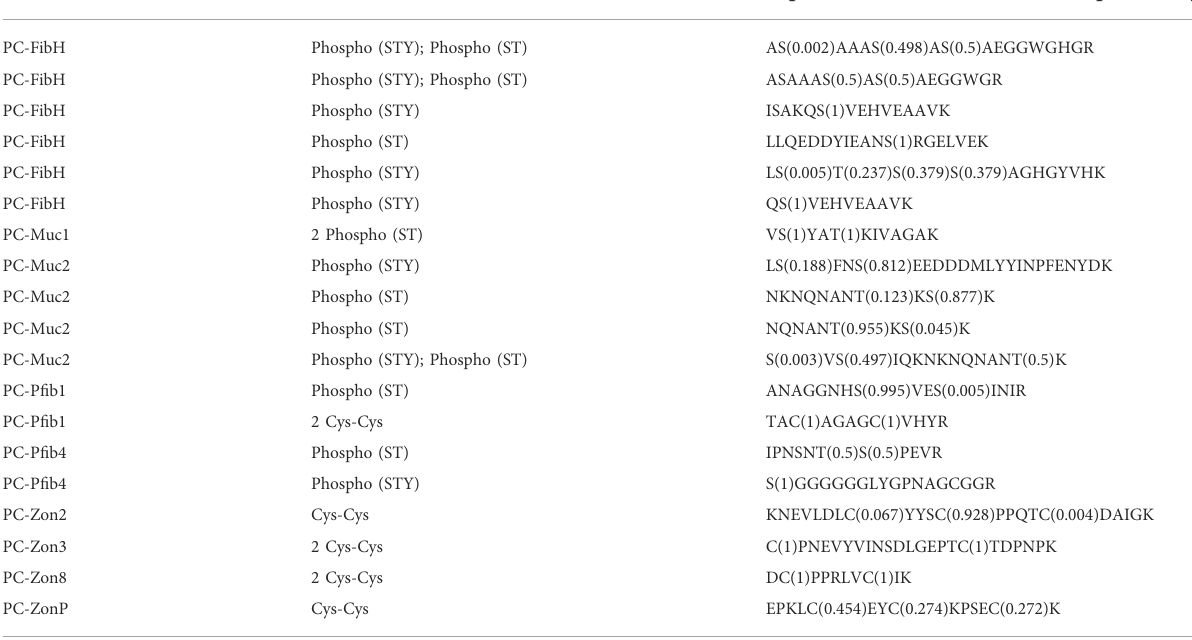
TABLE 3 Posttranslational modi fi cations detected in the silk fi bers by the peptide mass spectrometry. Protein Modi fi cations Peptide (Modi fi cation localization